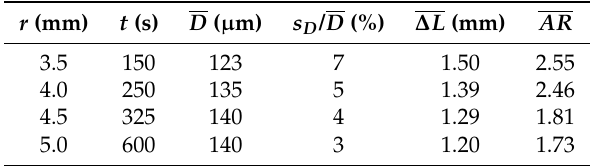
Table 2. Mean geometrical parameters for sets of nozzles of approximately the same diameter produced with different heating conditions. Capillaries type 1, z = 15